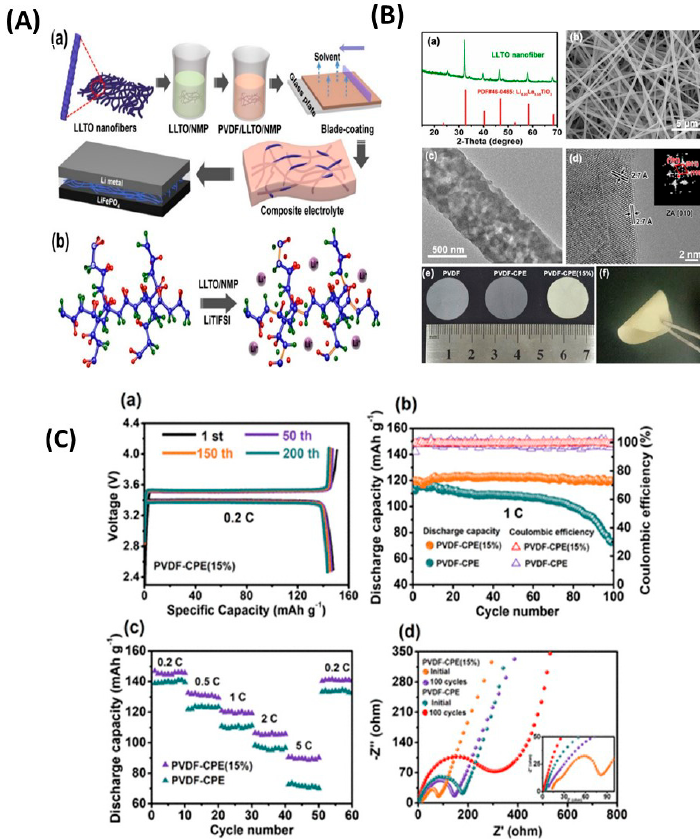
Figure 35. ( A ) Schematic illustration of the preparation procedure of the PVDF–CPEs, and illustration of the electrode configuration for the LMB. Here PVDF, CPE, and LMB denote polyvinylidene fluoride, composite polymer electrolyte, and lithium-metal battery, respectively ( a ). Schematic diagram of changes in PVDF molecular linkages in composite electrolytes( b ). ( B ) X-ray diffraction pattern ( a ), field-emission scanning electron micrograph ( b ), transmission electron micrograph ( c ), and high-resolution transmission electron micrograph ( d ) of LLTO nanofibers; the inset in ( d ) is the corresponding fast Fourier transform pattern of the LLTO nanofibers. Digital photographs of PVDF, PVDF–CPE, and PVDF–CPE (15%) membranes ( e ). Digital photograph of bent PVDF–CPE (15%) illustrating its good flexibility ( f ). ( C ) Performances of all-solid-state batteries at 25 °C. Charge–discharge curves of the Li|PVDF–CPE (15%)|LiFePO 4 cell at the current rate of 0.2C ( a ). Long-term cycling ( b ) and rate performances of PVDF–CPE and PVDF–CPE (15%) at the current rate of 1C ( c ). Electrochemical impedance spectroscopy profiles of batteries with PVDF–CPE and PVDF–CPE (15%) electrolytes before cycling and after 100 cycles at the current rate of 0.2C ( d ). Reproduced with permission from [495]. Copyright 2019 American Chemical Society.